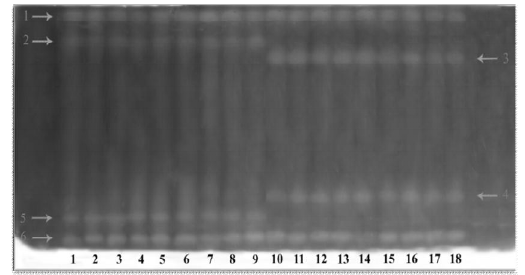
Fig. 7. Electrophoretic patterns of superoxide dismutase isoenzyme bands in different populations of N. complanata and N. crispa . The frequency values ranged from 0 to 1. The mean number of allozymes for each isozyme varied from 1.00 to 2.50. The average value of the Shannon diversity index (H) calculated for each population ranged from 0.665, in N.c. N